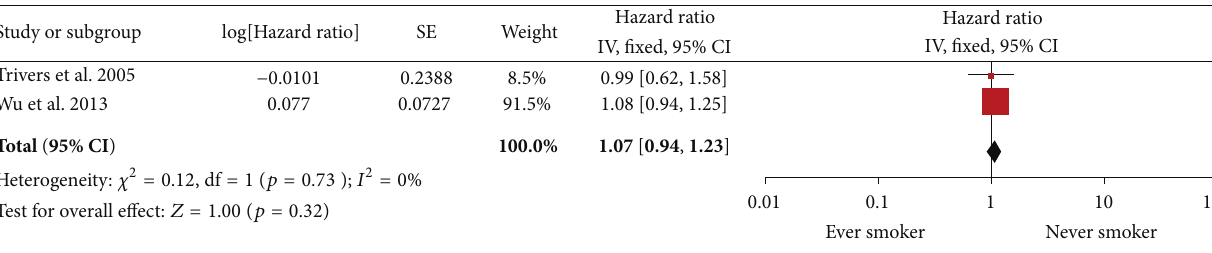
Figure 6: Ever versus never